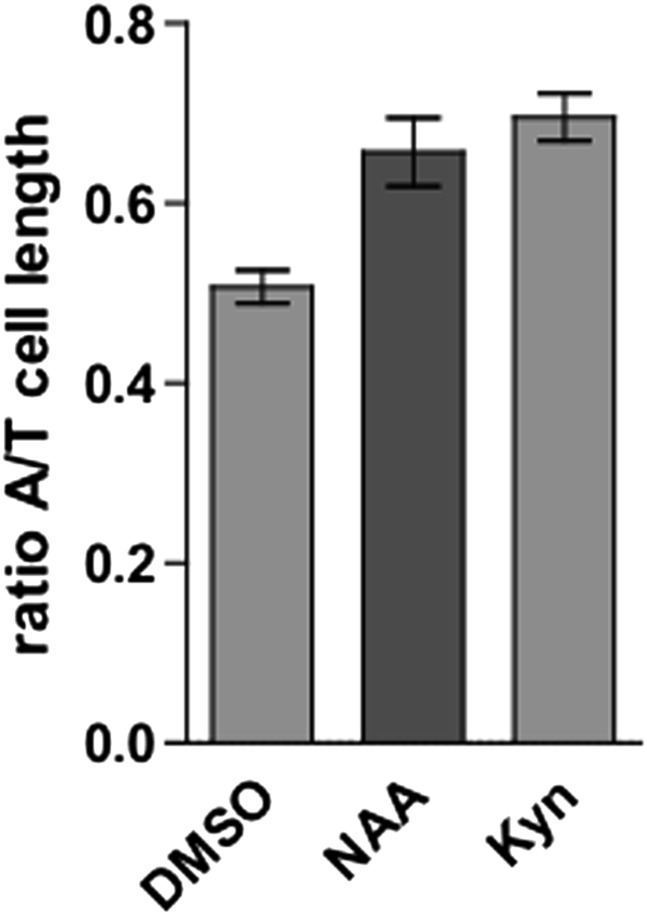
DOI:
http://dx.doi.org/10.7554/eLife.05868.025